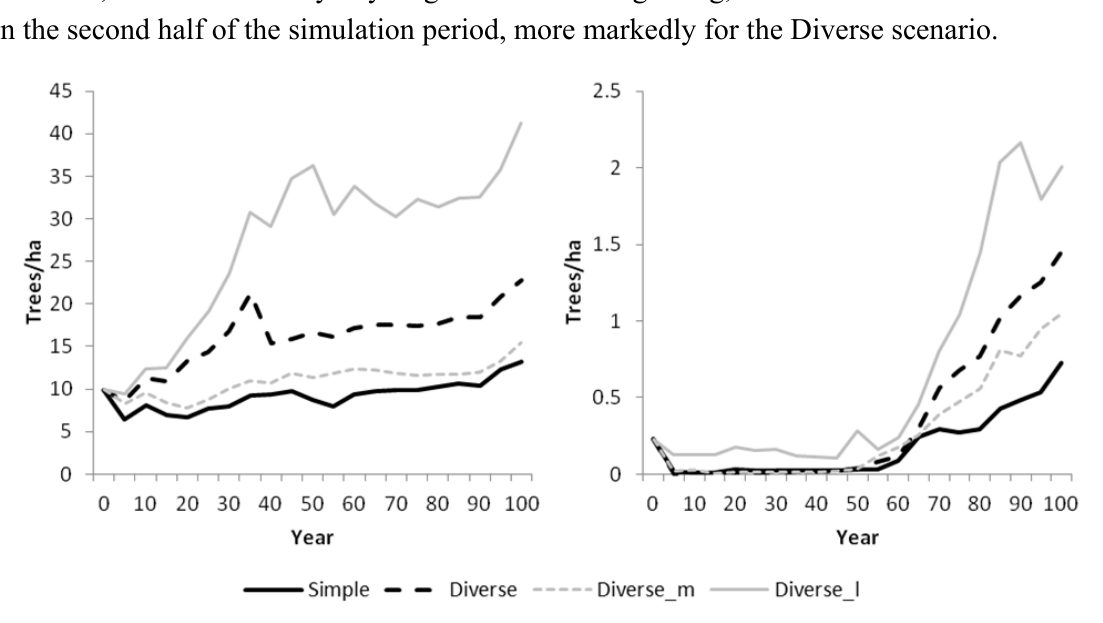
Figure 9. Average number of large trees per ha in Hässleholm ( left ) and Vilhelmina ( right ), for the Simple and Diverse scenarios, as well as the more intensive (Diverse_m) and less intensive (Diverse_l) variations of the Diverse scenario. NB: different scales on y